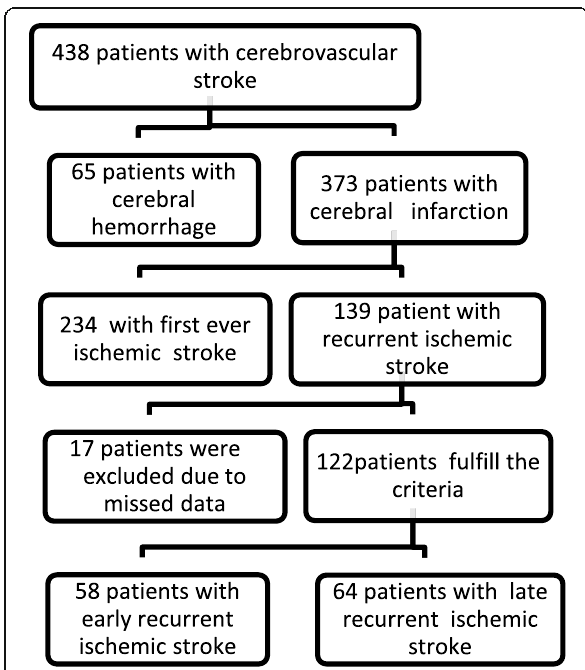
Table 2 Demographic data and risk factors in both groups